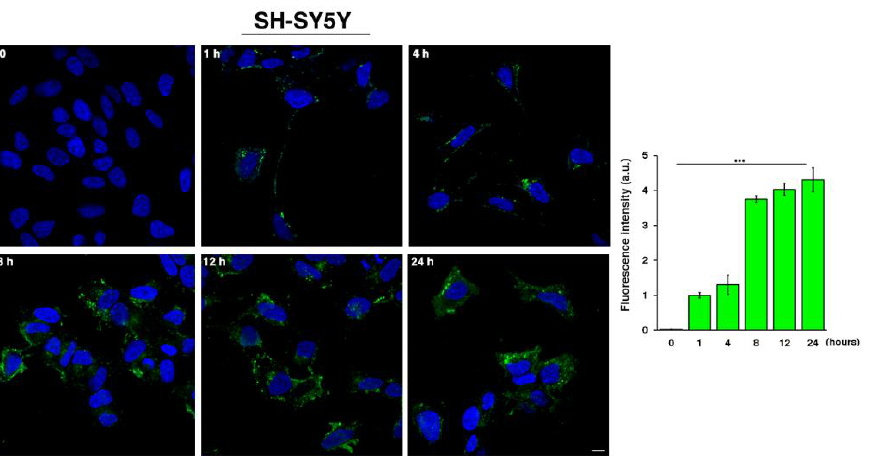
Figure 6. Time-course analysis of MS3 cell uptake. SH-SY5Y cells were incubated with a 4 µM solution of FITC-MS3 (green) at the indicated time points and fixed; then, nuclei were stained with DAPI (blue). Images were acquired with confocal microscope. Scale bar, 6 µm. Mean fluorescence intensity normalized per cell area (arbitrary unit, a.u.) of three independent experiments is shown (left graph), n > 50 cells; error bars, mean ± SD. *** p < 0.0001, Student t -test.